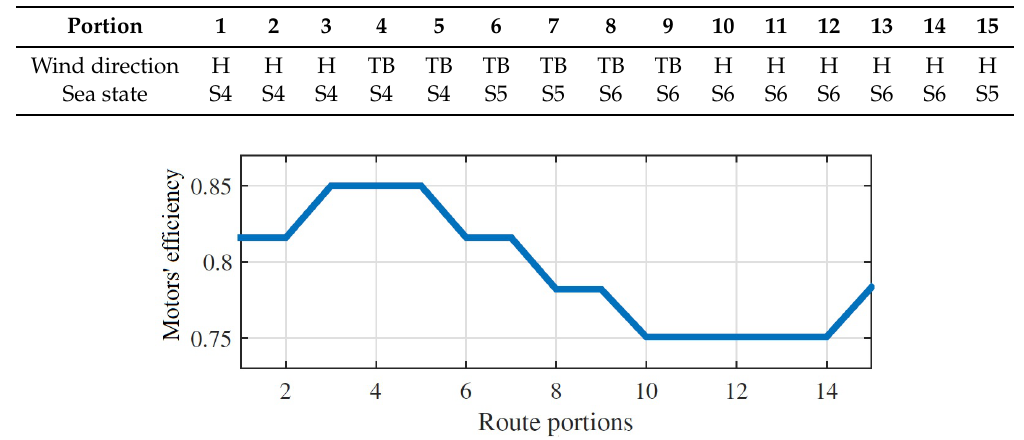
Table 3. Wind direction and sea state in different portion of the trip.